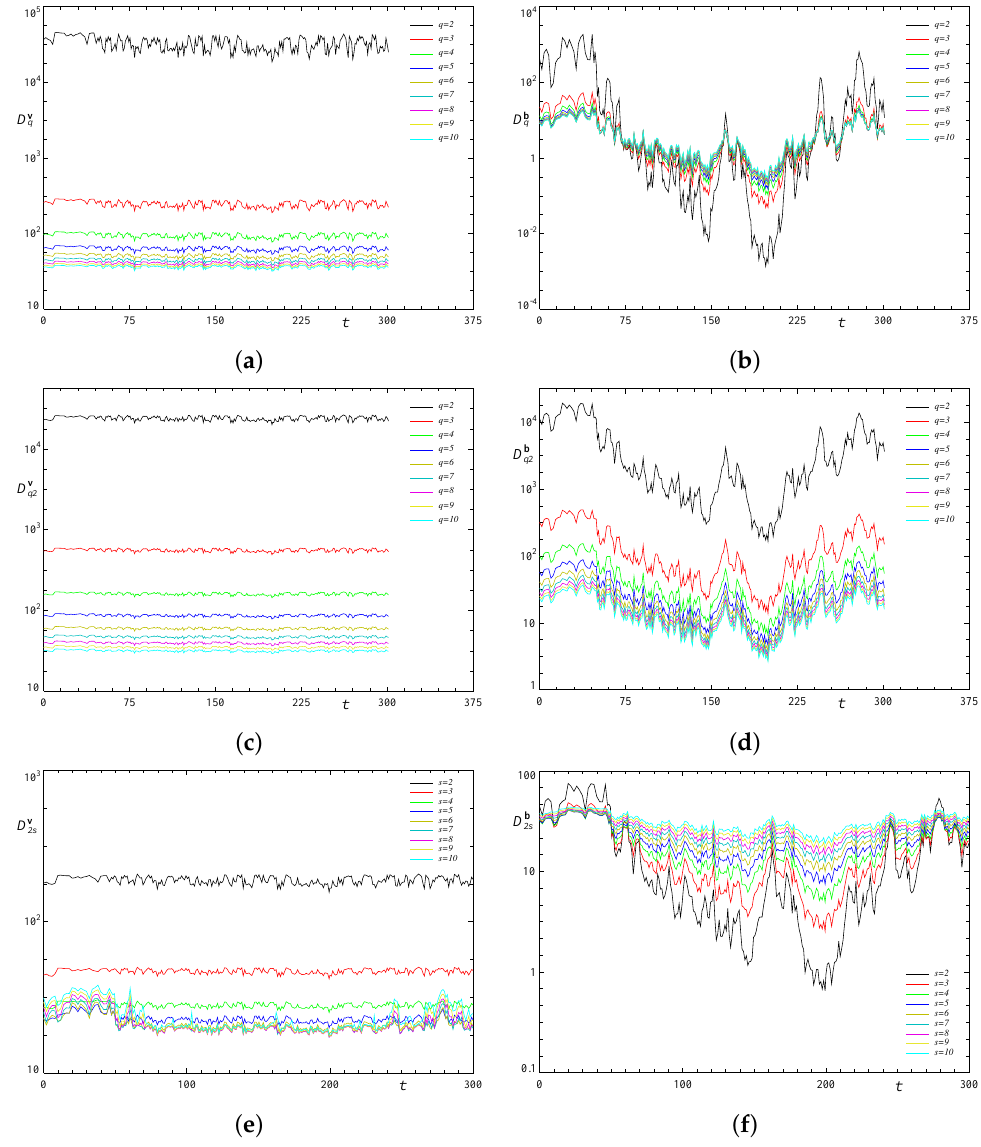
Figure 29. Time evolution of the quantities D v q (a), D v q , s (c), (e), D b q (b) and D b q , s (d), (f) for s = 2 and q varying in the range 2 ≤ q ≤ 10 (c), (d), and for q = 2 and s in the range 1 ≤ s ≤ 10 (e), (f) in run 4 x